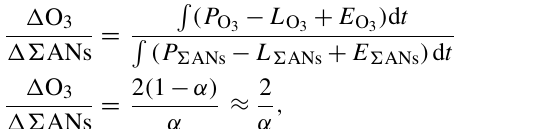
Figure 7. O 3 versus (cid:54) ANs measured between 11:00 and 13:00UTC during PARADE (red data points) and NOTOMO (black data points). The red line is the best fit for PARADE. For NOTOMO the black line is chosen to encompass all possible values of α , as- suming a background O 3 level of 15ppbv. The apparent, poor reso- lution in the NOTOMO data is due to the low yield and the iterative correction procedure as described in the